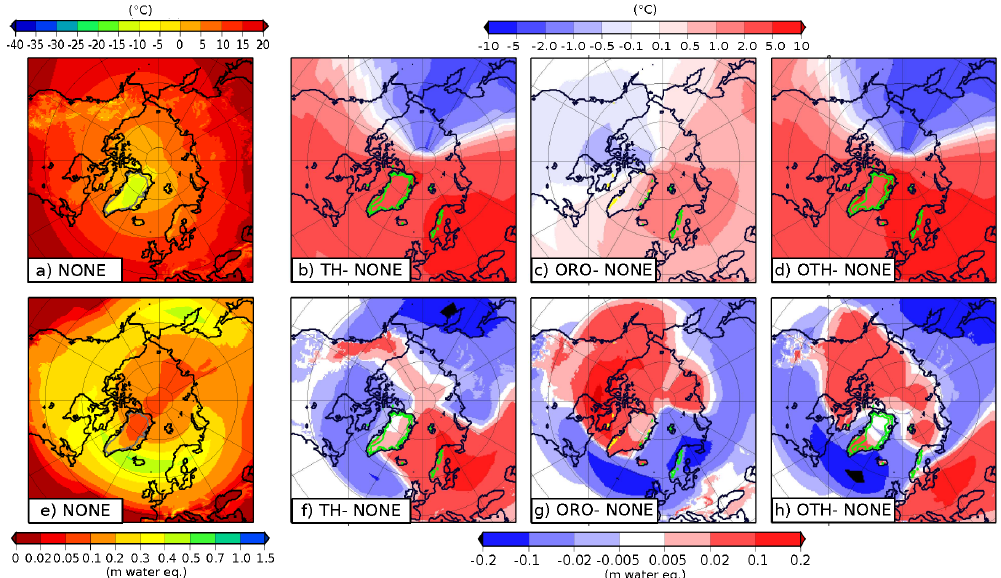
Fig. 2. Summer surface temperature at 125ka in NONE-REF experiment (parameterization of SLP are removed) (a) , difference of summer surface air temperature between TH-REF (thermal parameterization) and NONE-REF (b) ; ORO-REF (orographic parameterization) and NONE-REF (c) and OTH-REF (combination of both thermal and orographic parameterization) and NONE-REF (c) at 125ka. Same for the snow accumulation (e–h) . The green line represents the limit where the ice thickness difference exceeds −